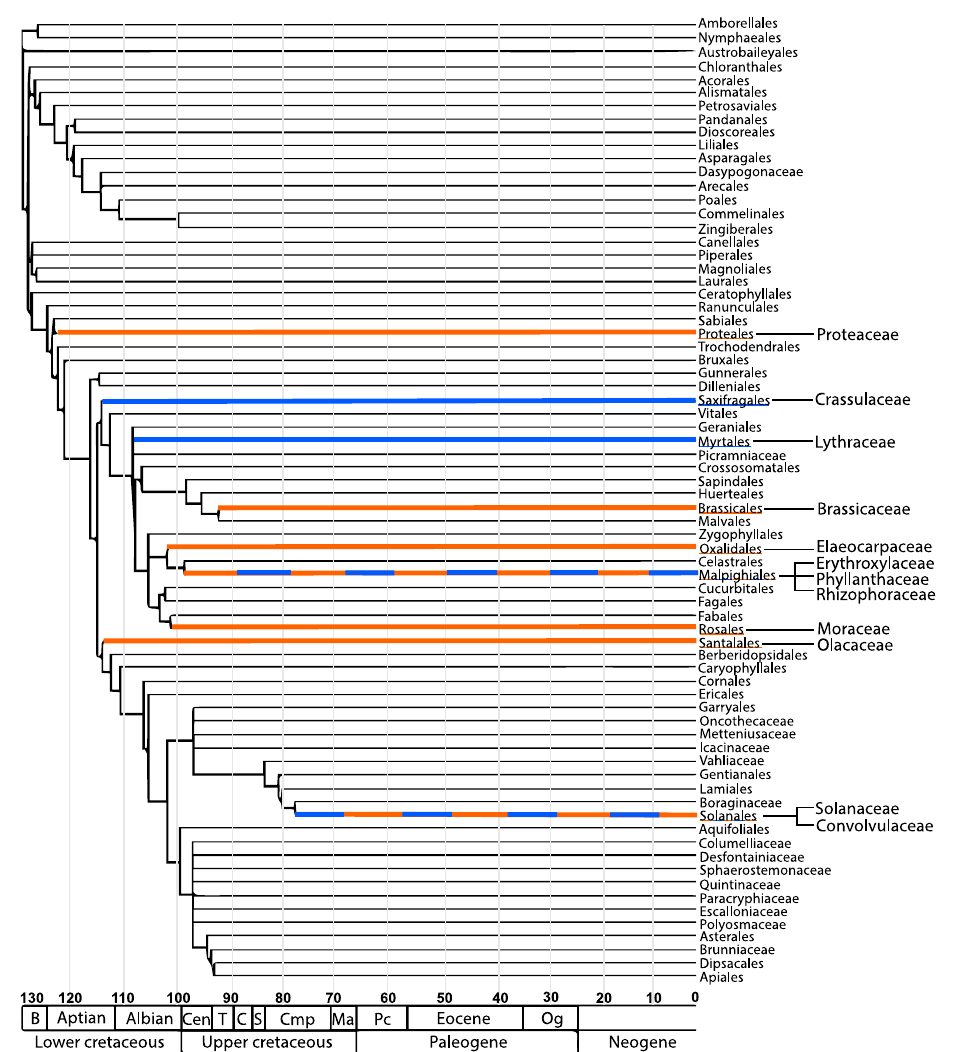
Figure 3. The diversity and similarities of tropane and granatane producing angiosperms. The orders tropane alkaloids belong to are highlighted in orange. The orders granatane alkaloids belong to are highlighted in blue. Shared orders are represented by both colors. The plant families that are known to produce tropane and granatane alkaloids are branched off from the orders. The scale at the bottom represents millions of years. Modification of the phylogenetic tree published in [54], republished with permission with the Botanical Society of America.